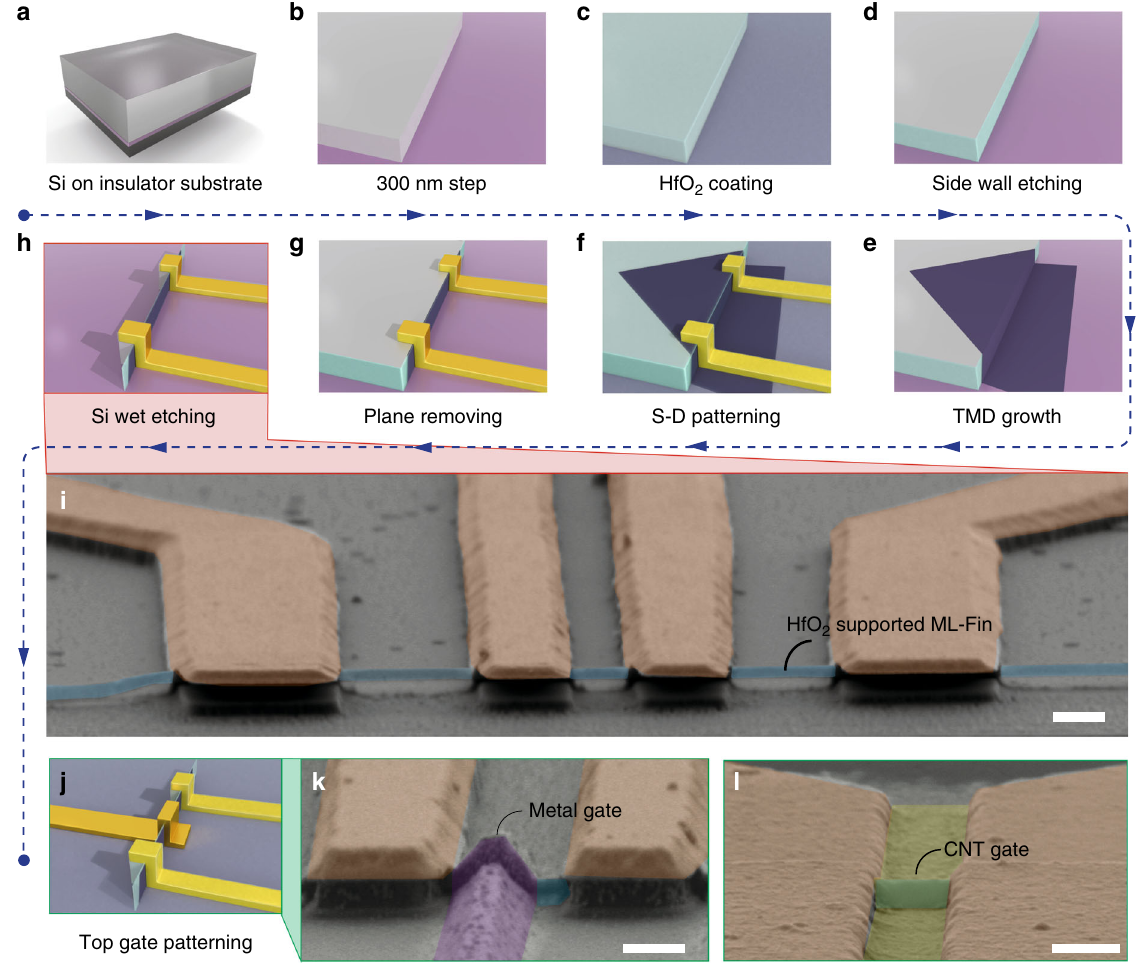
Fig. 2 Fabrication of ML-FinFETs. a – h Schematic images of the detailed process for fabricating the ML-FinFETs, with the name of each step labeled below. i Zoomed-in false-colored SEM image of a typical vertically clamped ML MoS 2 , corresponding to the h . j Gate electrodes deposited on the HfO 2 -coated structure in h , fi nishing the whole process of ML-FinFET fabrication. k , l False-colored SEM images of the ML-FinFET with metal and CNT- fi lm gates, respectively. Scale bars in i , k , l are 500, 500 and 200 nm,